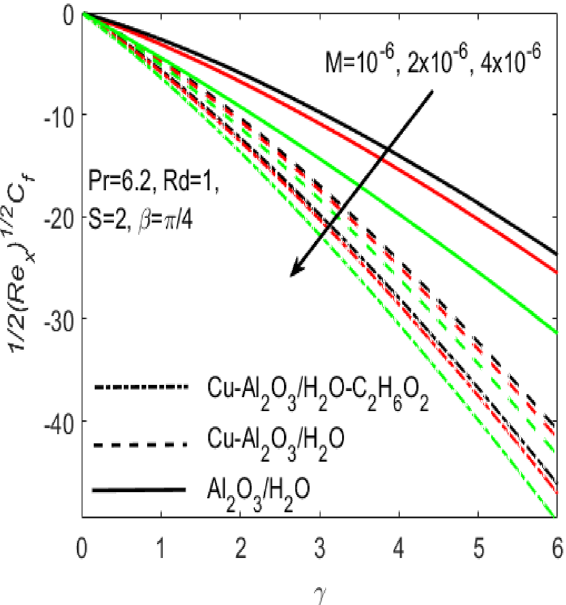
Figure 9. Influence of M on C f for different hybrid nanofluids and simple